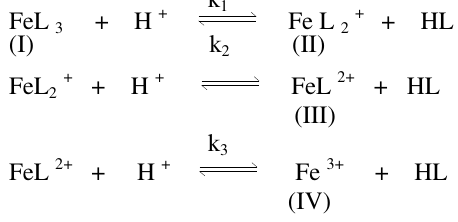
Table 1. Effect of GSH concentration on rate.